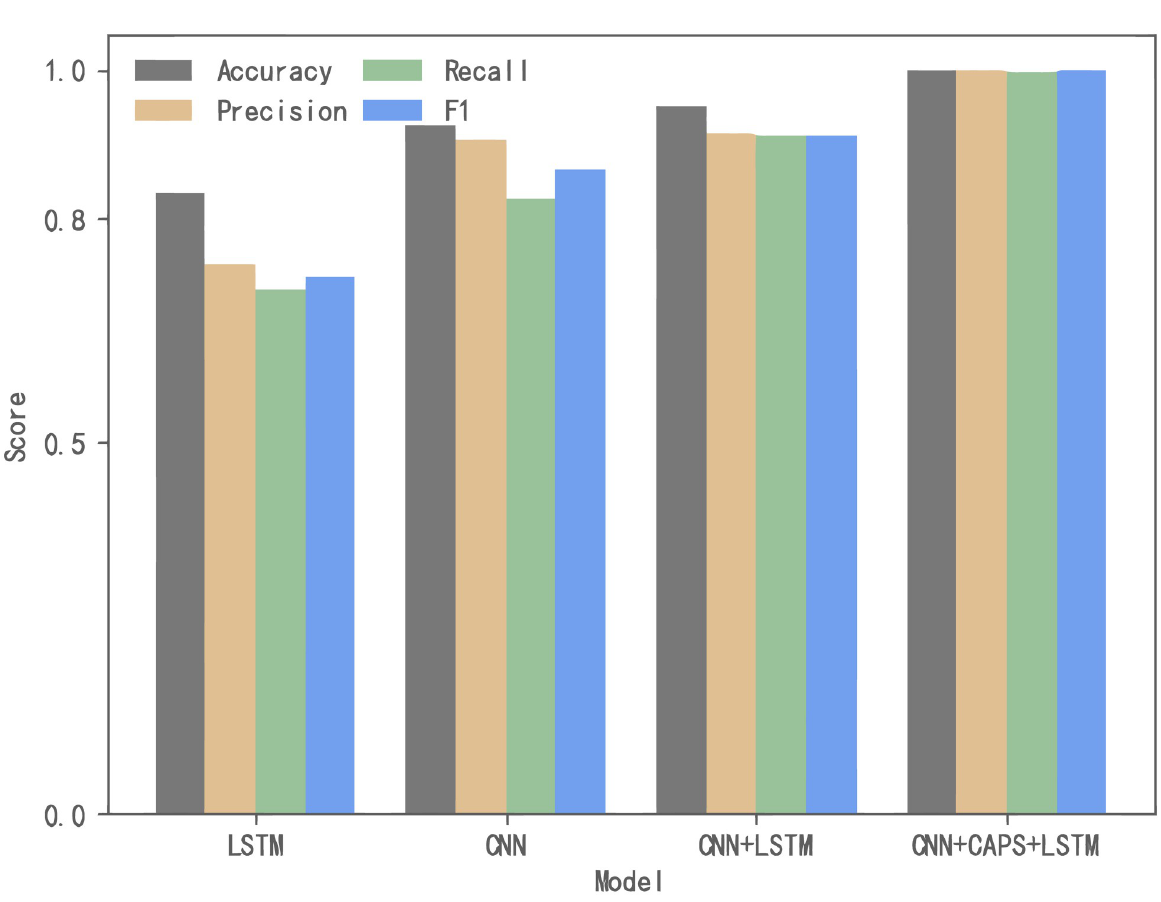
Fig 11. Evaluation of feature extraction